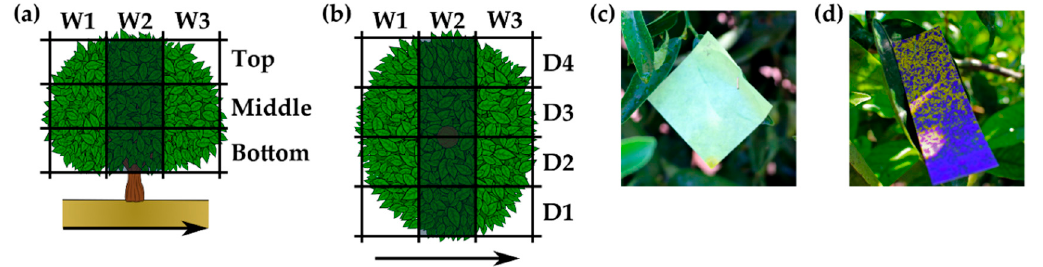
Figure 6. Quadrants of the canopy where the collectors were placed (shaded): ( a ) side view along the row and ( b ) top view. The arrows indicate the direction of the sprayer. Collectors used: ( c ) filter paper to estimate leaf deposition and ( d ) water-sensitive paper (WSP) to estimate spray coverage.